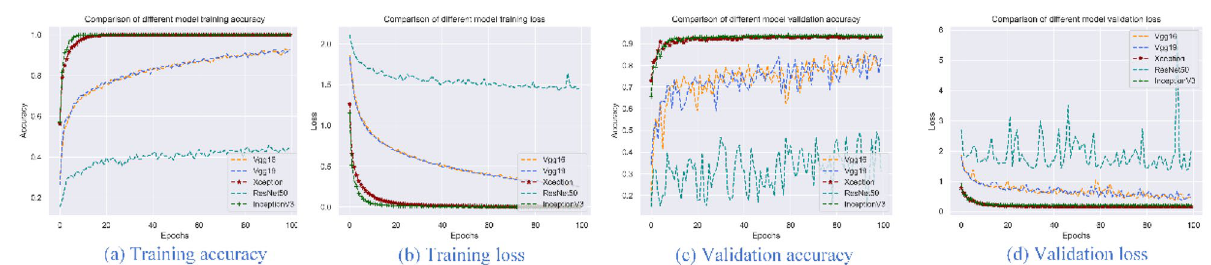
Figure 2. Accuracy and loss for five different models using image_clip data.